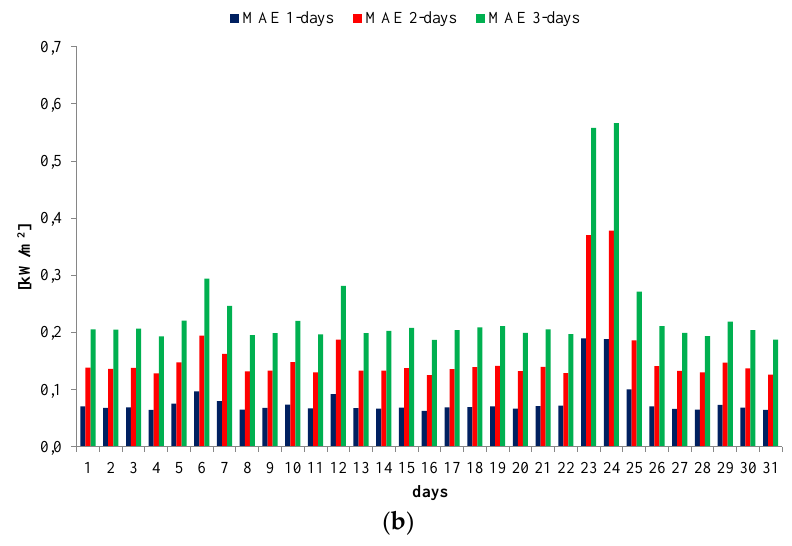
Figure 5. The MAE in kW/m 2 in July. ( a ) Site “Gi”; ( b ) Site “Ma”.